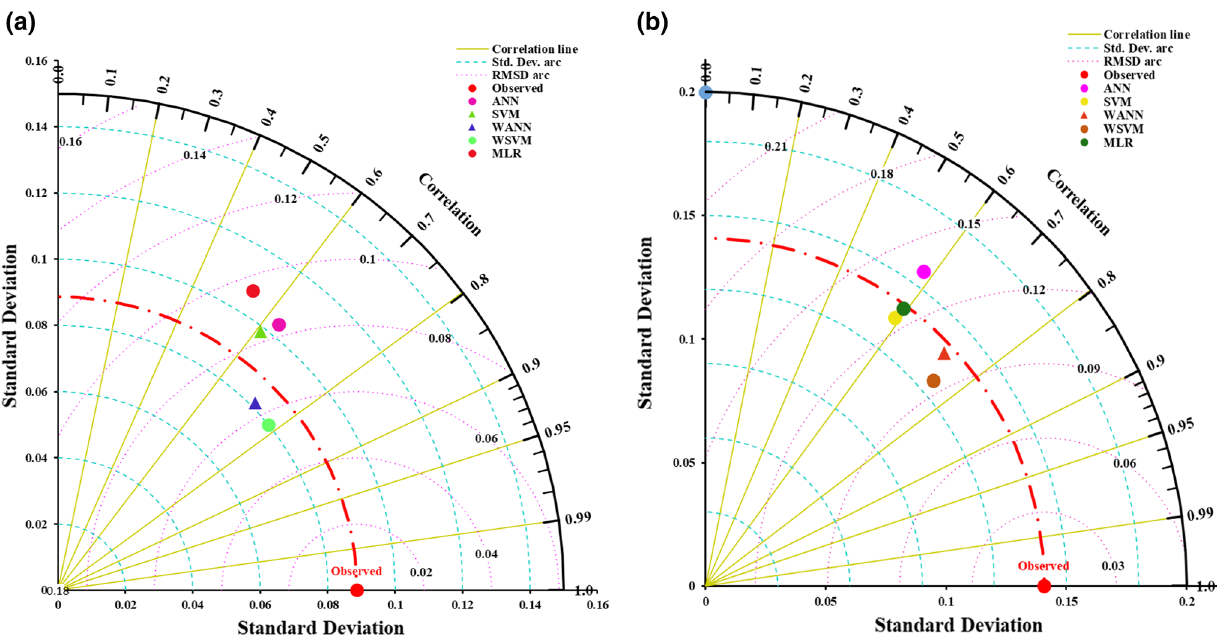
Fig. 12 Taylor diagram of ANN, SVM, WANN, WSVM, and MLR models during the testing period at a Adityapur site and b Ghatshila